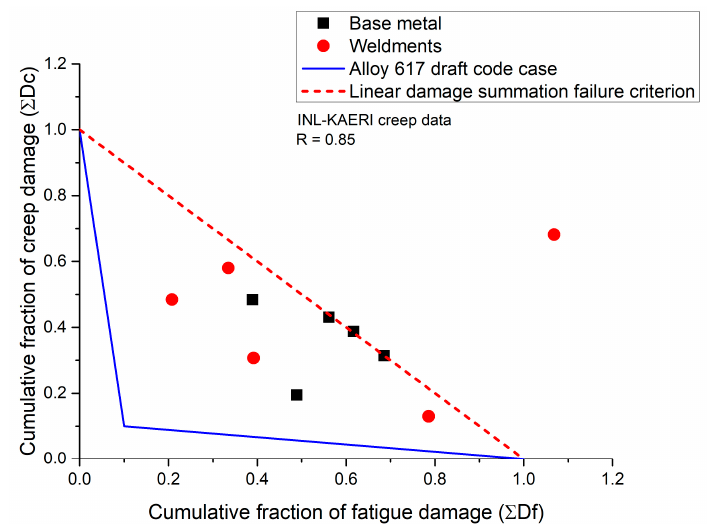
Figure 12. Creep-fatigue interaction diagram based on linear damage summation showing the cumulative fraction of creep vs. fatigue damage of Alloy 617. Red dashed line shows the ideal failure criterion of linear damage summation and the bilinear blue line is the failure criterion of the draft code case for Alloy 617.